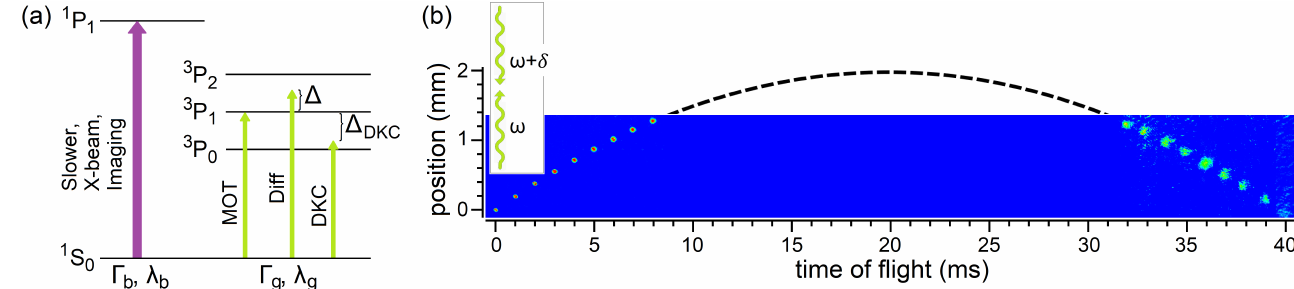
Figure 1. ( a ) Energy level diagram for ytterbium showing the optical transitions used in the experiment; ( b ) demonstration of a vertical fountain launch with 30 ground-band Bloch oscillations. The relative frequency sweep of the lattice beams was ˙ δ = 2 π × 600 kHz/ms. Time-of-flight absorption images show the trajectory of the atom cloud at variable times following the launch. The dashed line indicates the part of the trajectory that is out of view of the absorption imaging